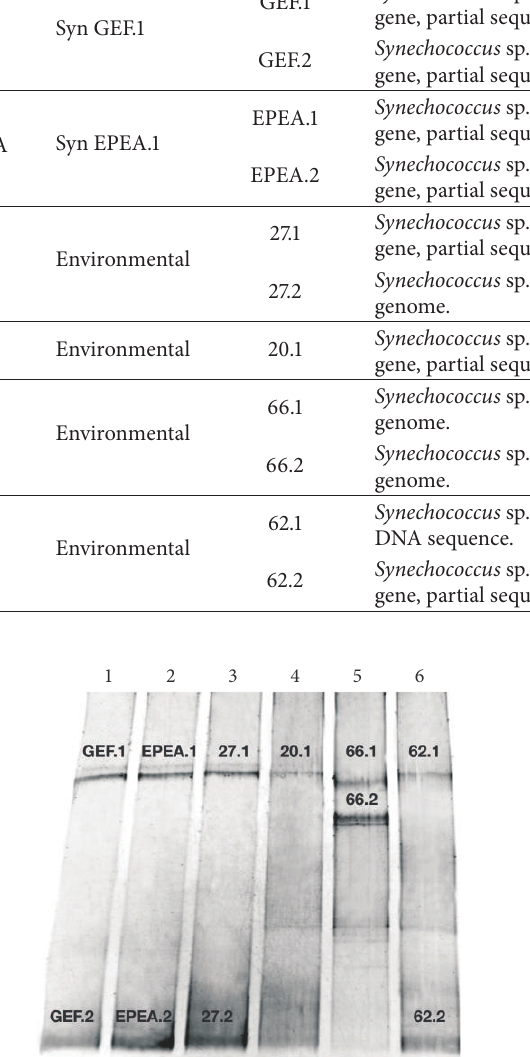
Figure 2: Denaturing gradient gel electrophoresis analysis of PCR amplified 16S rRNA gene segments obtained from environmental samples of the Argentine Sea. Syn-GEF.1 (lane 1) and Syn-EPEA.1 (lane 2) isolates were used as references. Lanes 3 and 5: shelf stations 27 and 66, respectively; lanes 4 and 6: oceanic stations 20 and 62, respectively. Labeled bands were excised for further